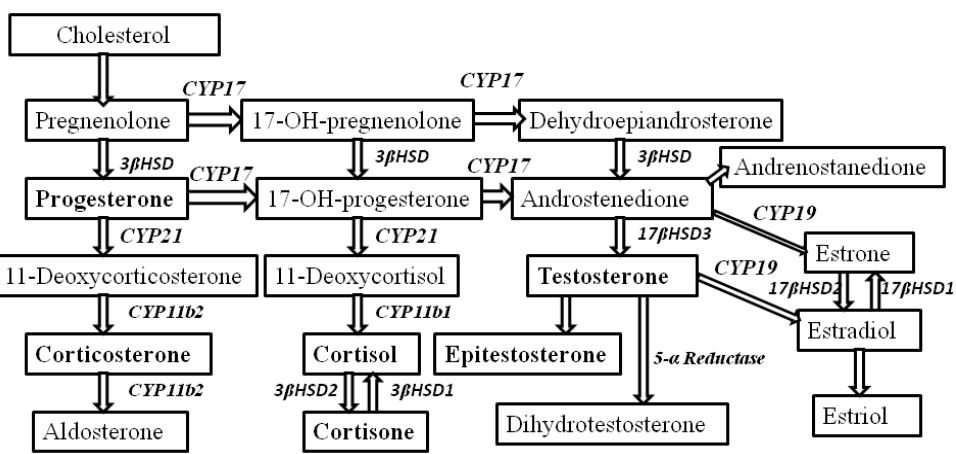
Figure 1. Biosynthesis of steroid hormones from the cholesterol